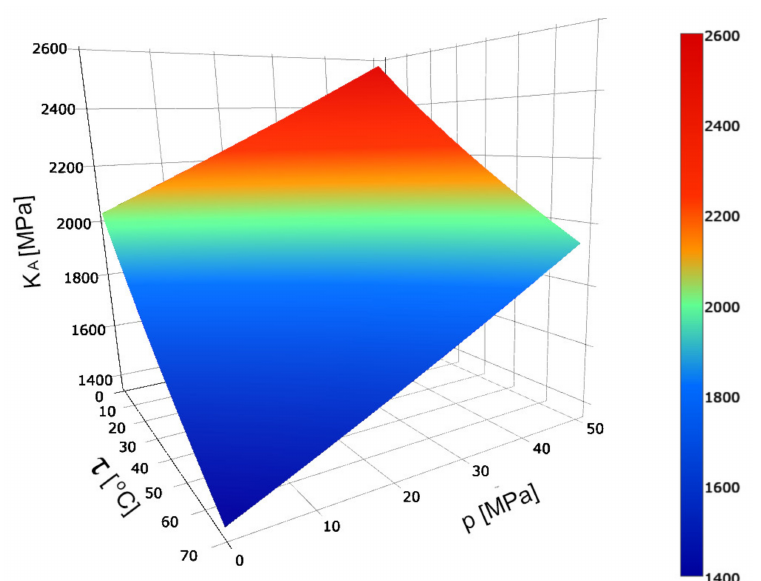
Figure 11. Characteristics of the adiabatic, tangent bulk modulus K A as a function of pressure p and temperature τ for Total Azolla ZS 46 oil